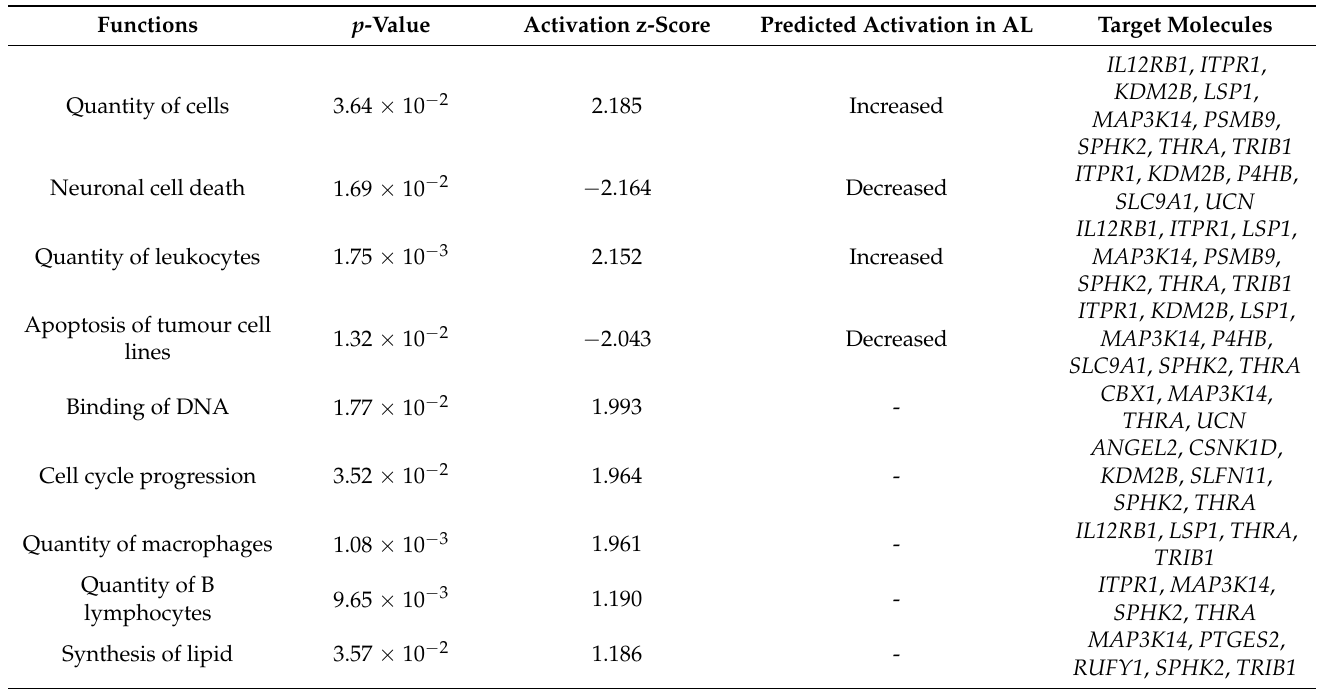
Table 2. Top functions found with IPA associated with the target molecules in the Deseq2 dataset and their respective predicted activation state in Alentejano pigs